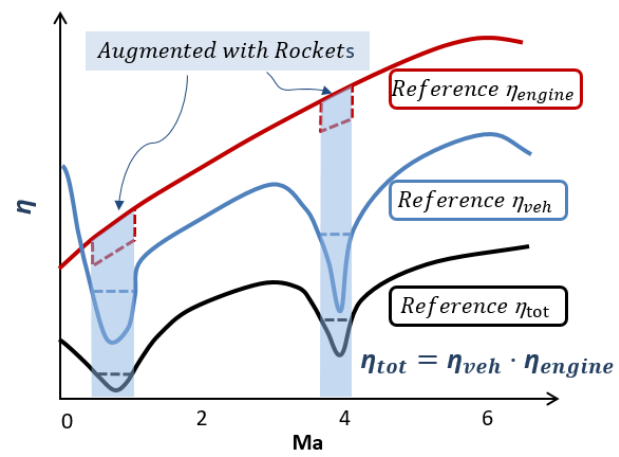
Figure 3. Total efficiency might be improved by rockets. Figure 3. Total e ffi ciency might be improved by